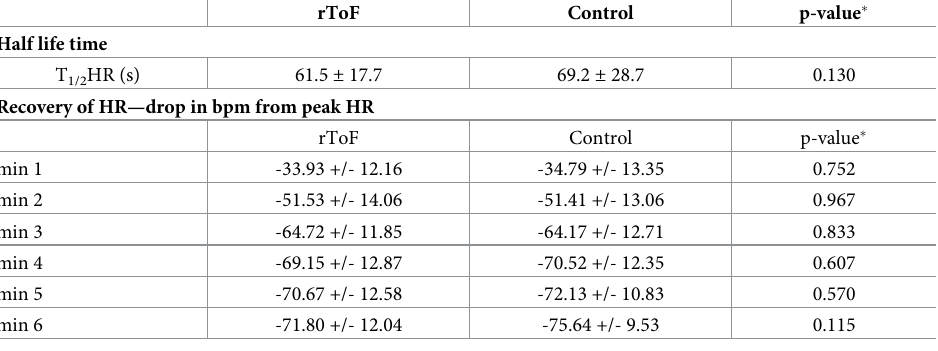
Table 4. Recovery parameters of